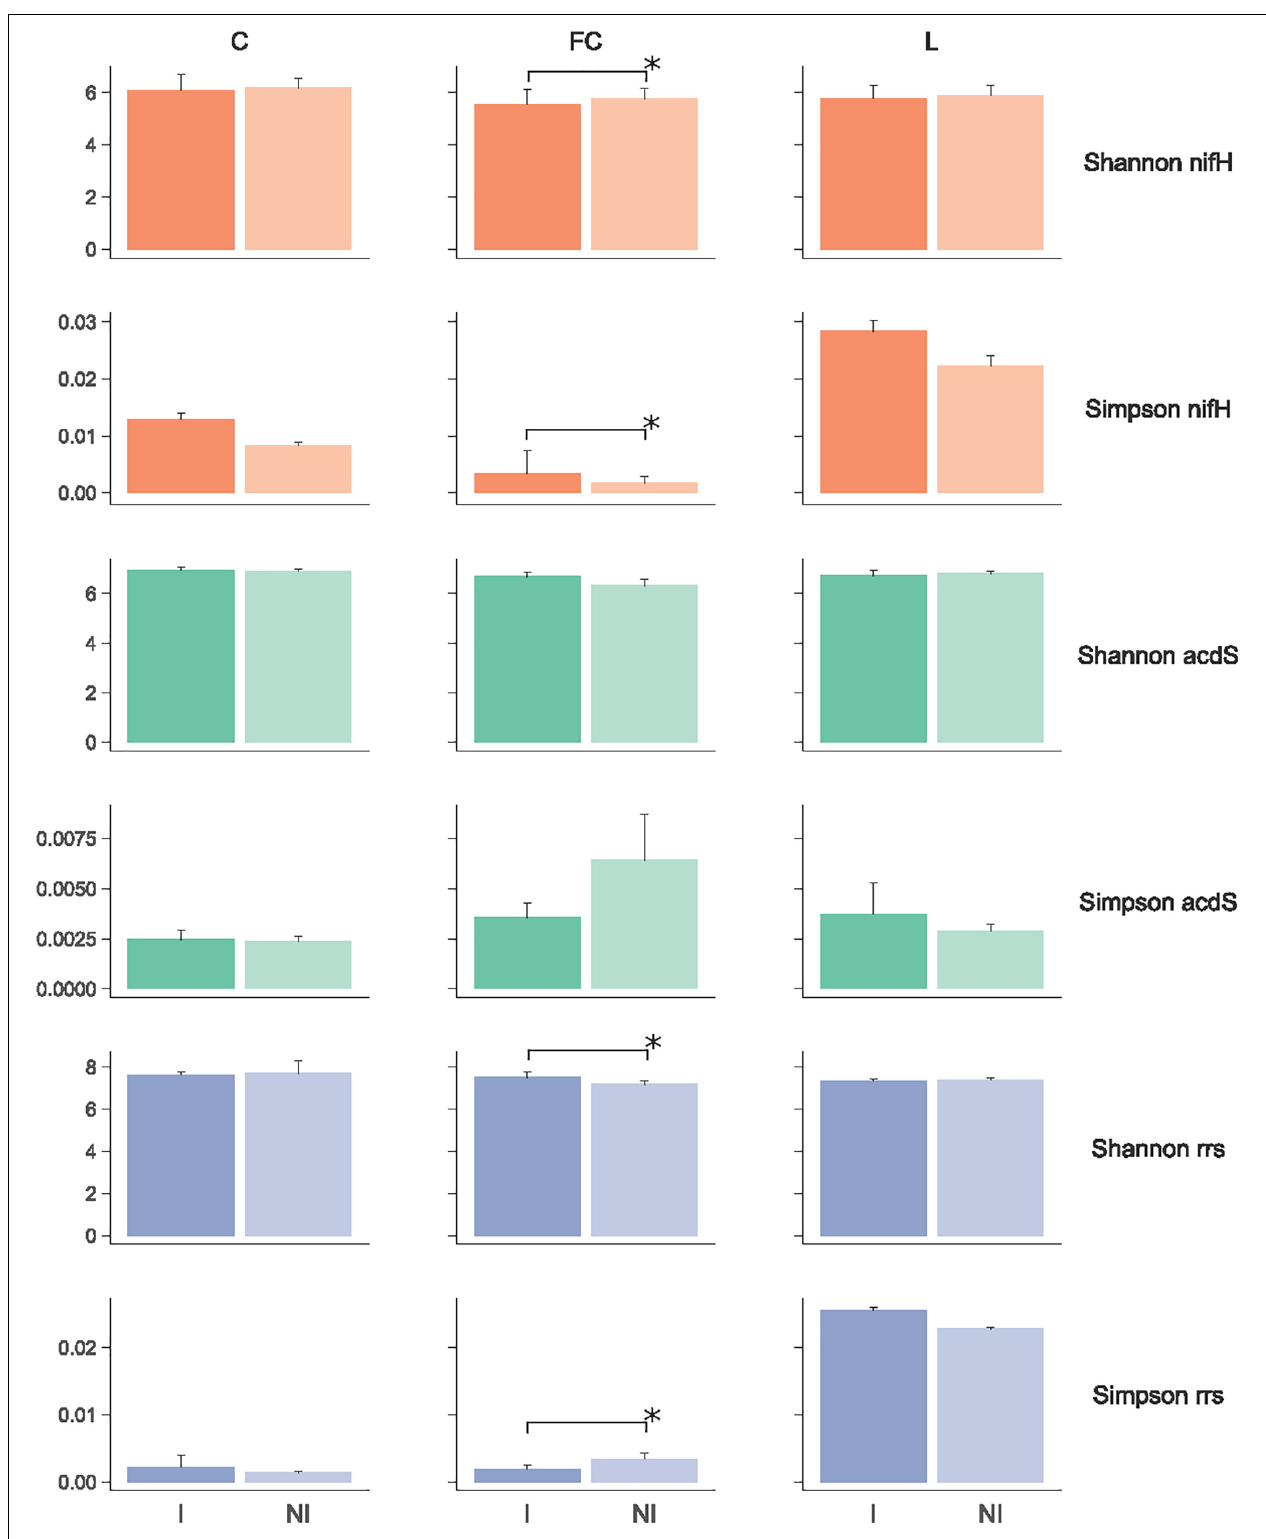
FIGURE 1 | Diversity indices of nifH and acdS functional groups and the entire ( rrs ) bacterial community at sites L, FC, and C. NI and I correspond, respectively, to non-inoculated and inoculated conditions. Data are shown using means ± standard deviations ( n = 5). Statistical analyses were carried out by Wilcoxon test between inoculated and non-inoculated conditions, and differences are shown with an asterisk ( p < 0.05).